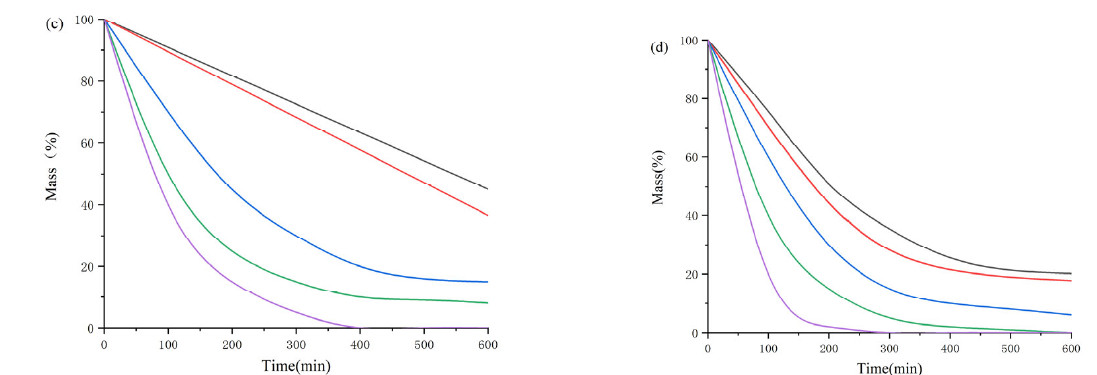
Figure 4. Isothermal TGA curves of five ionic liquids at 240 ◦ C ( a ), 250 ◦ C ( b ), 260 ◦ C ( c ) and 270 ◦ C ( d ). ([Emmim][NO 3 ], [Bmmim][NO 3 ], [Hmmim][NO 3 ], [Ommim][NO 3 ] and [Dmmim][NO 3 ] are represented by black, red, blue, green and purple curves, respectively).